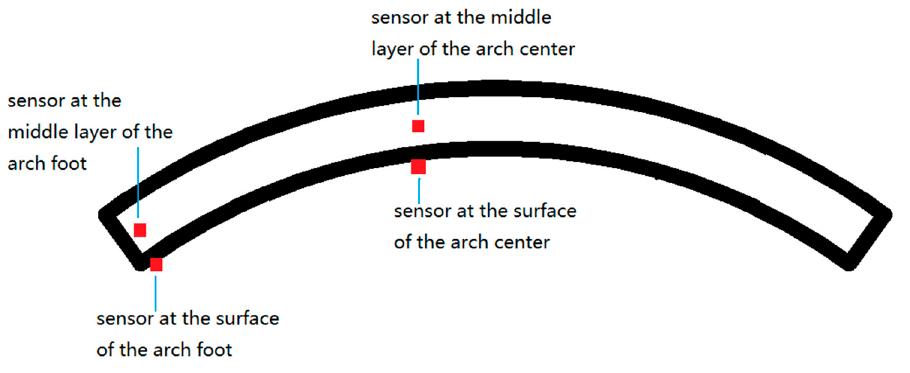
Figure 7. Location of thermal sensor.